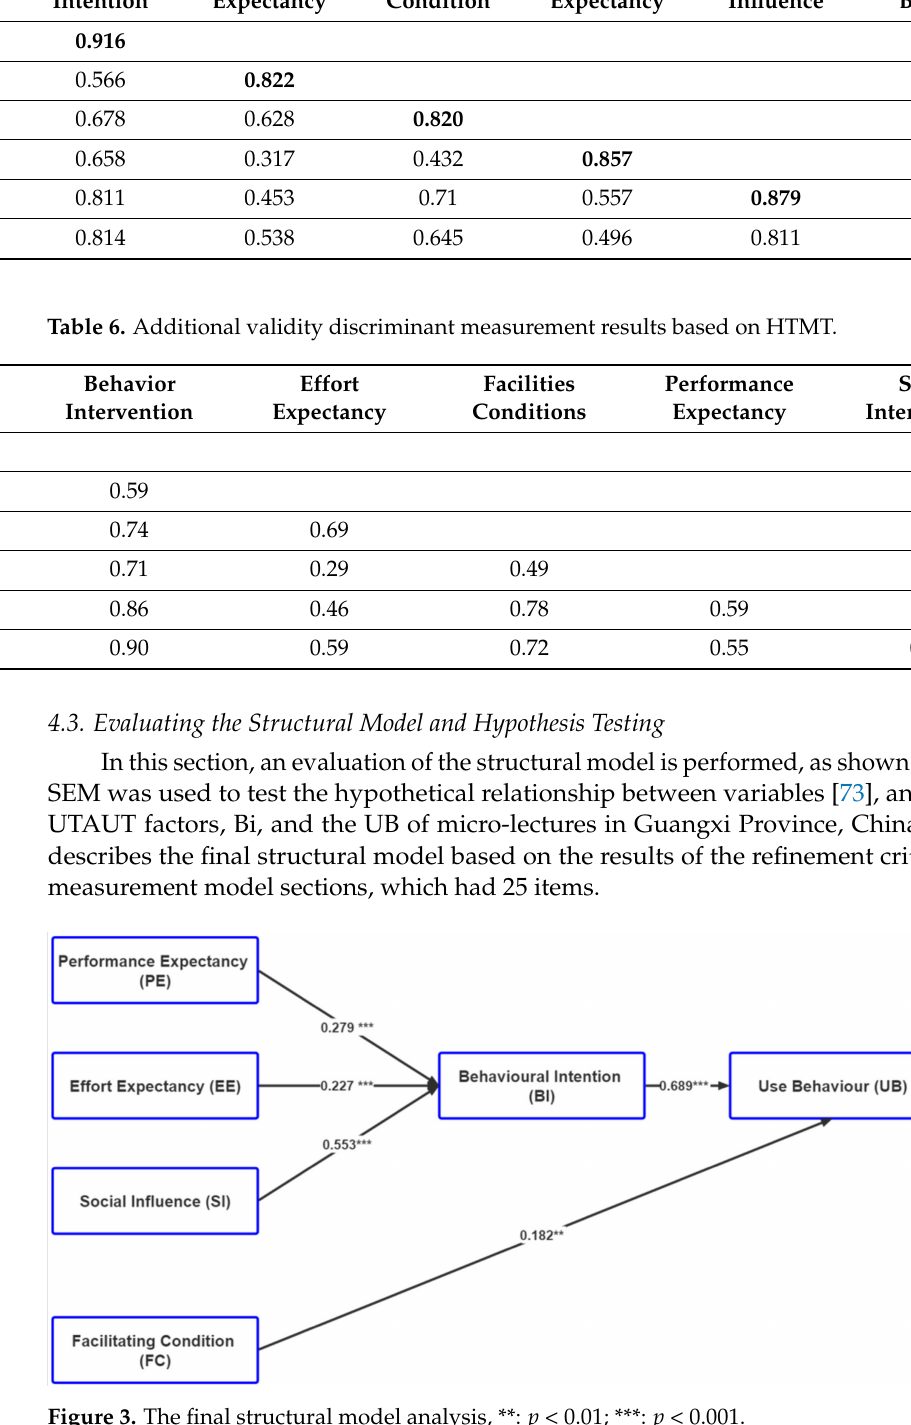
Figure 3. The final structural model analysis, **: p < 0.01; ***: p <